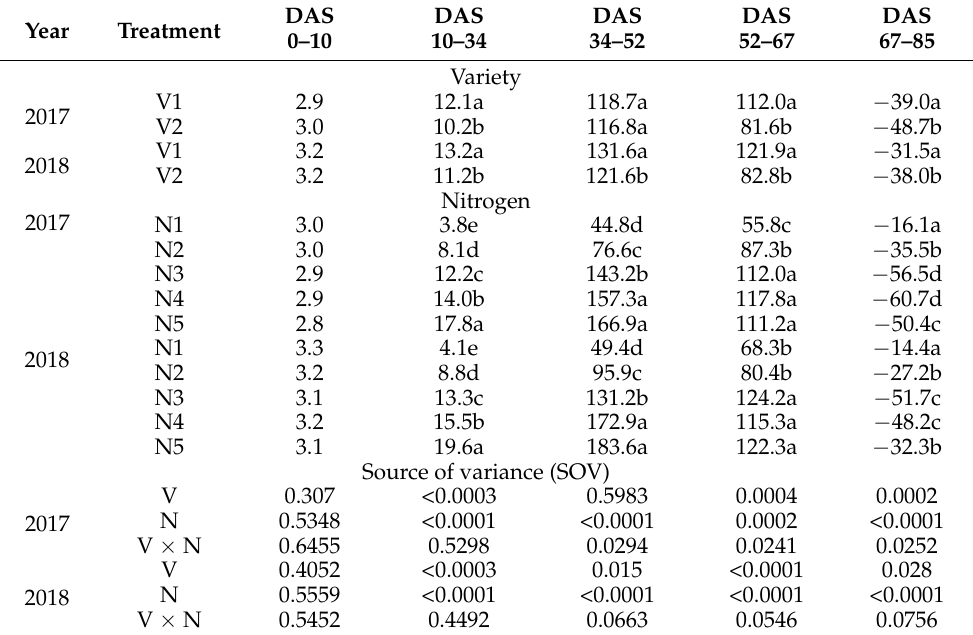
Table 2. Average accumulation rate of vegetative organ biomass (kg ha − 1 ) under different variety and nitrogen fertilization rates in 2017–2018.